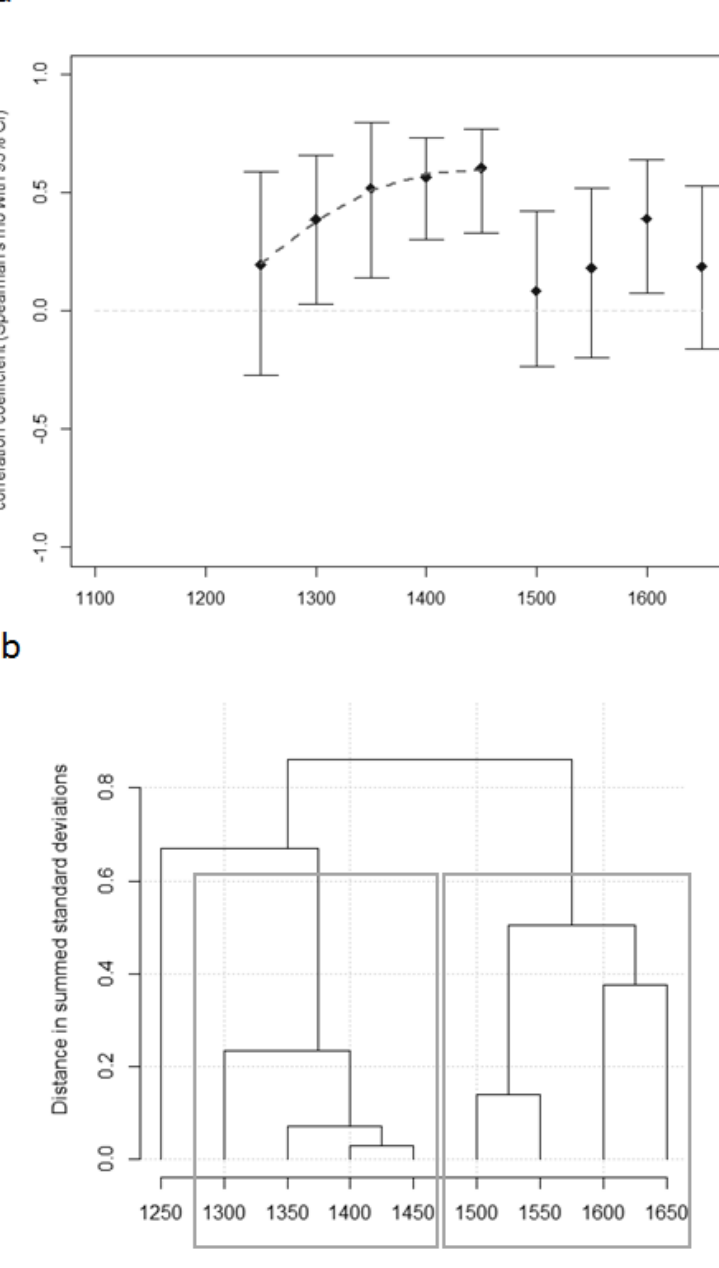
Figure 4. (a) Trajectory of estimated correlation coefficients (Spearman’s ρ ) together with 95% confidence intervals for all half-­‐centuries from 1250 to 1700. The dashed line corresponds to a fitted quadratic model (adjusted 𝑅 ! = . 99 , 𝑝 = . 004 ). From 1250 to 1500 a significant positive correlation is established. (b) VNC based dendrogram of the successive correlation coefficients. Between 1450 and 1500 a break in the diachronic development is clearly